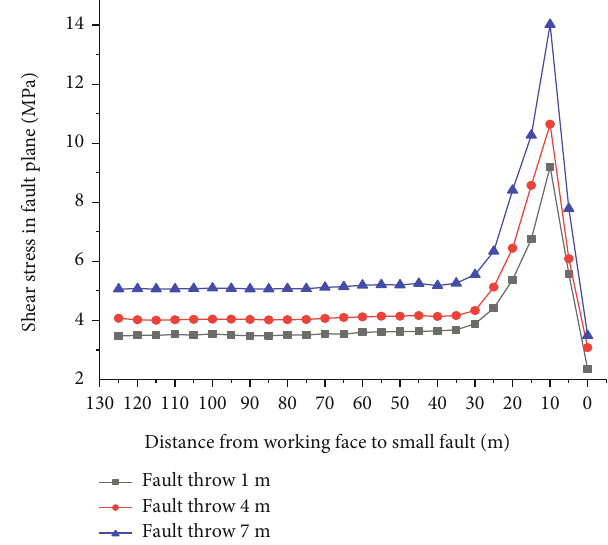
Figure 4: In fl uence of small fault drop on shear stress of fault plane. The black dotted line represents a fault throw of 1 m, the red dotted line represents a fault throw of 4 m, and the blue dotted line represents a fault throw of 7